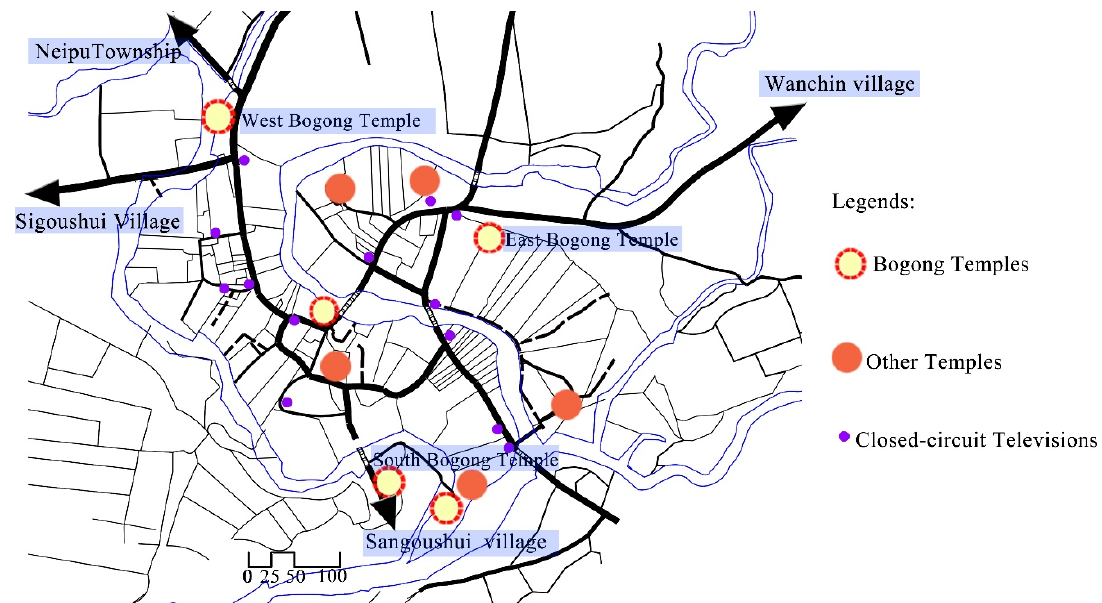
Figure 6. Current Status of the Defences of the Wugoushui Settlement.